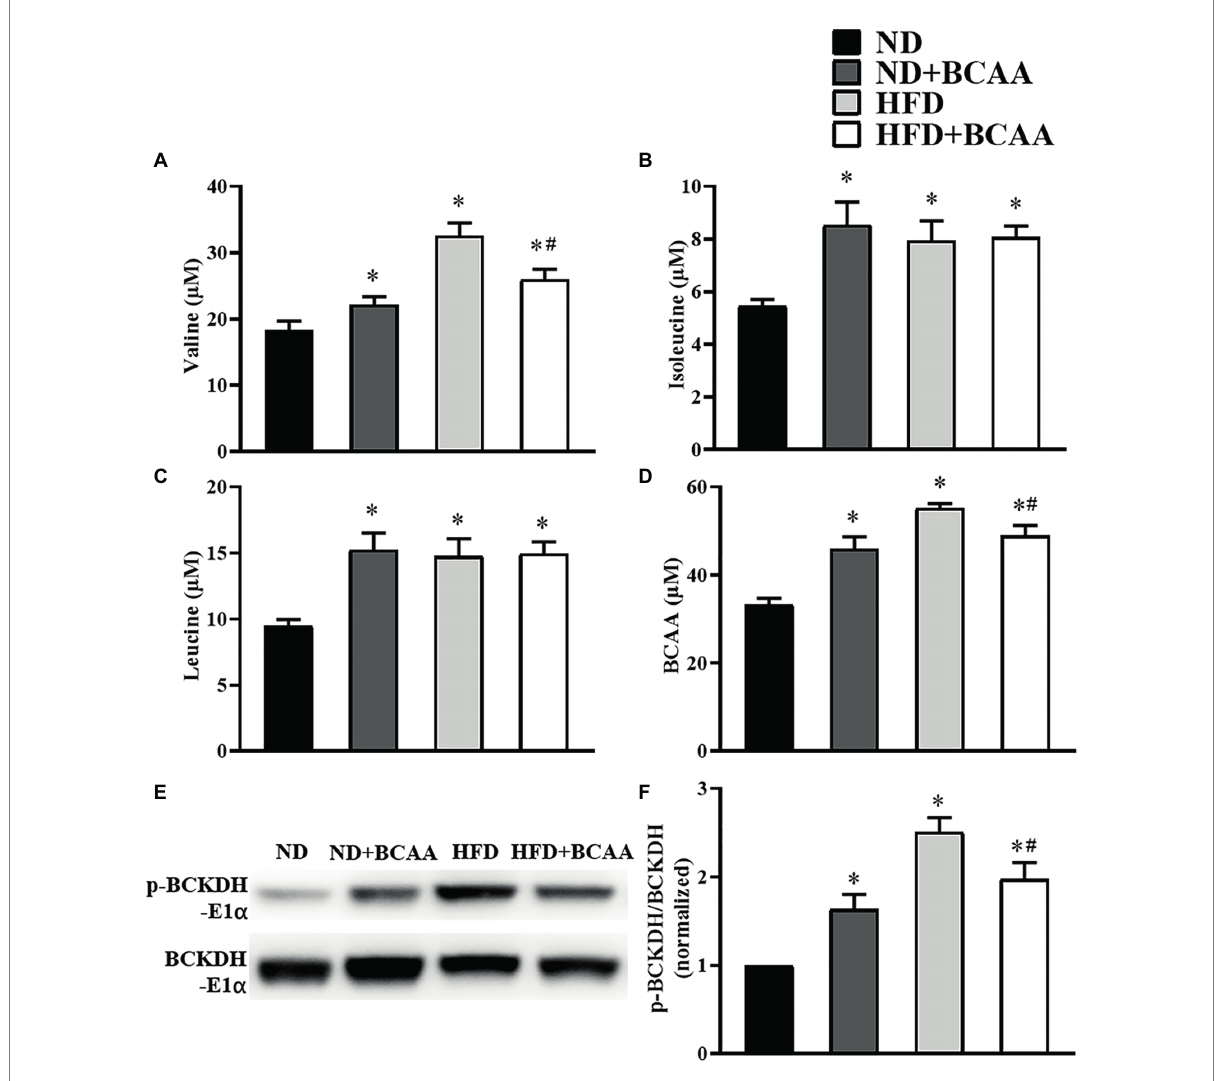
FIGURE 1 Effects of branched-chain amino acids (BCAAs) supplementation on BCAAs metabolic disorders induced by high-fat diet (HFD). Serum (A) valine, (B) isoleucine, (C) leucine, and (D) total BCAAs concentrations ( n = 10 for the ND, ND + BCAAs and HFD groups, n = 8 for the HFD + BCAAs group). (E) The protein expression of p-BCKDH-E1 α and BCKDH-E1 α in the liver. (F) The relative quantitative data for p-BCKDH-E1 α /BCKDH-E1 α as indicated ( n = 8). The densitometry is normalized to β -actin. The data are presented as the mean ± SEM. * p < 0.05 vs. the ND group; # p < 0.05 vs. the HFD